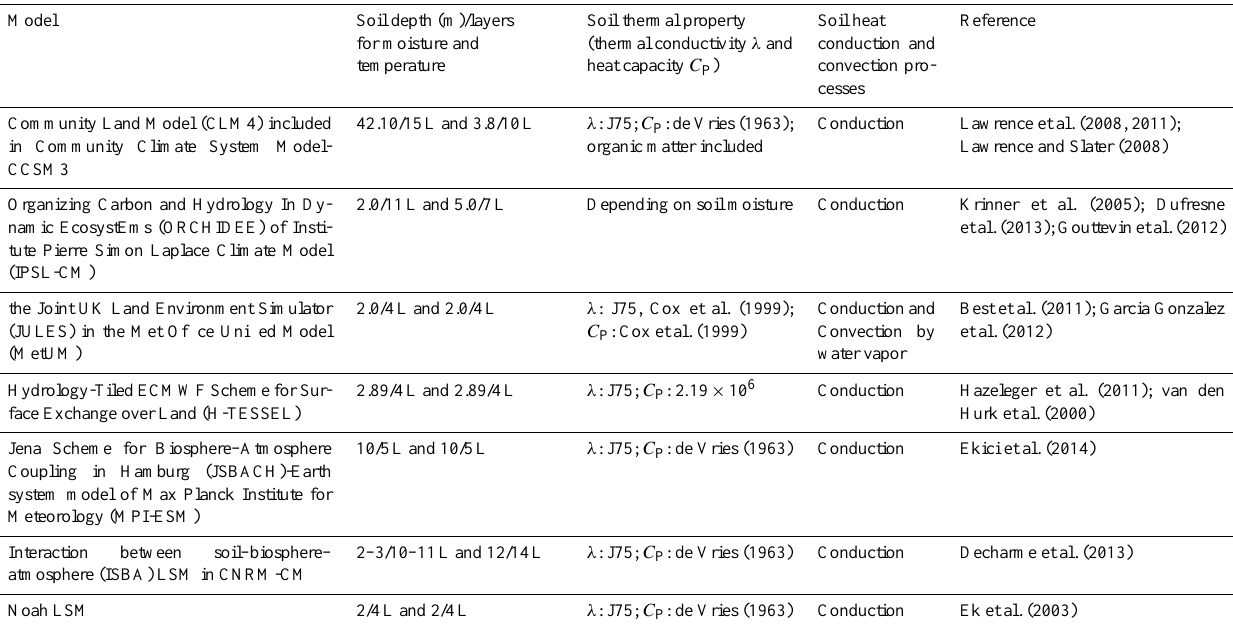
Table 1. The list of soil thermodynamics parameterizations in different LSMs/GCMs. Model Soil depth (m)/layers for moisture